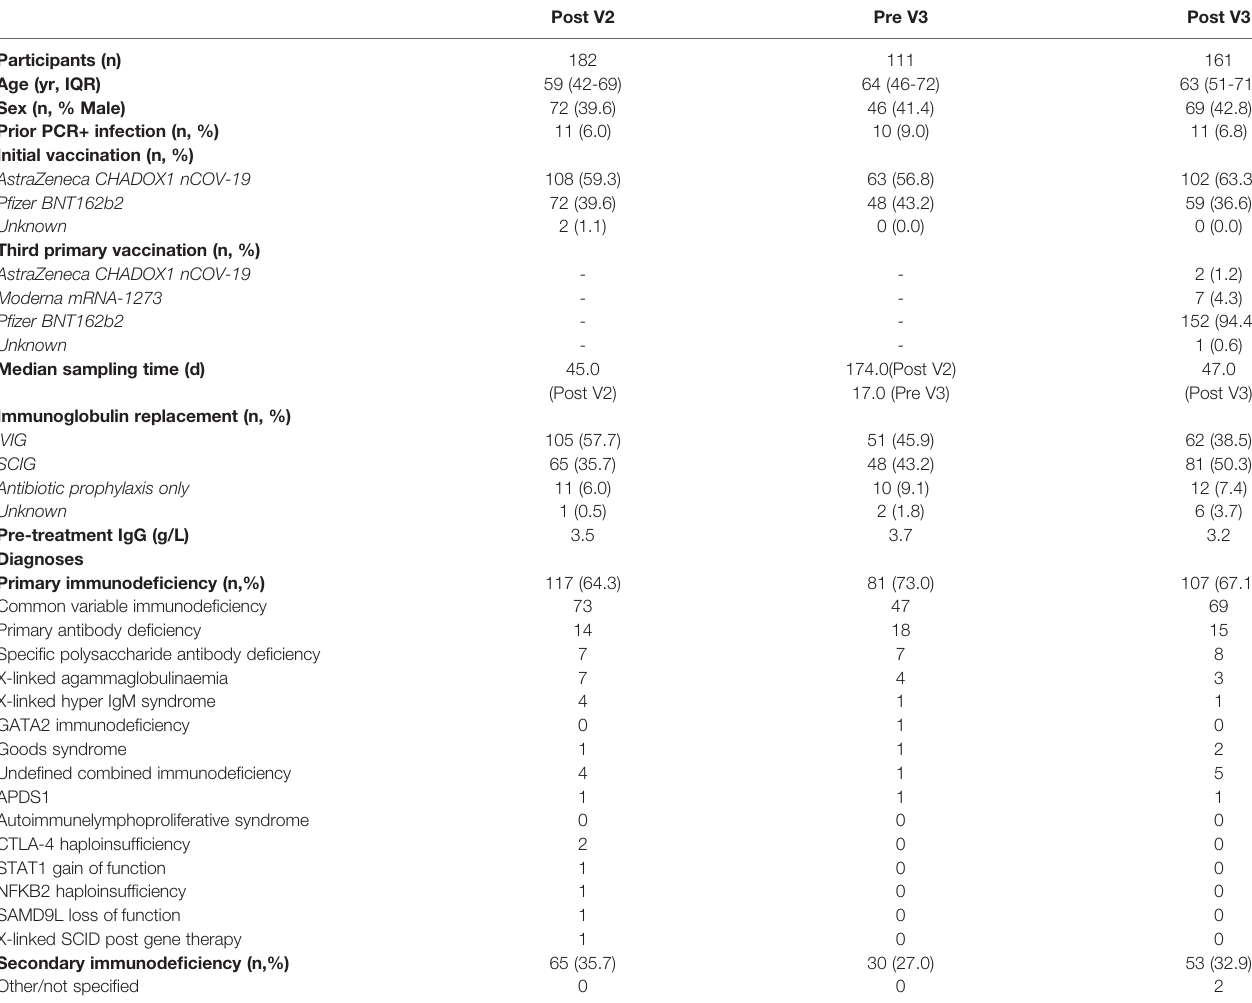
TABLE 1 | Demographics of COV-AD study